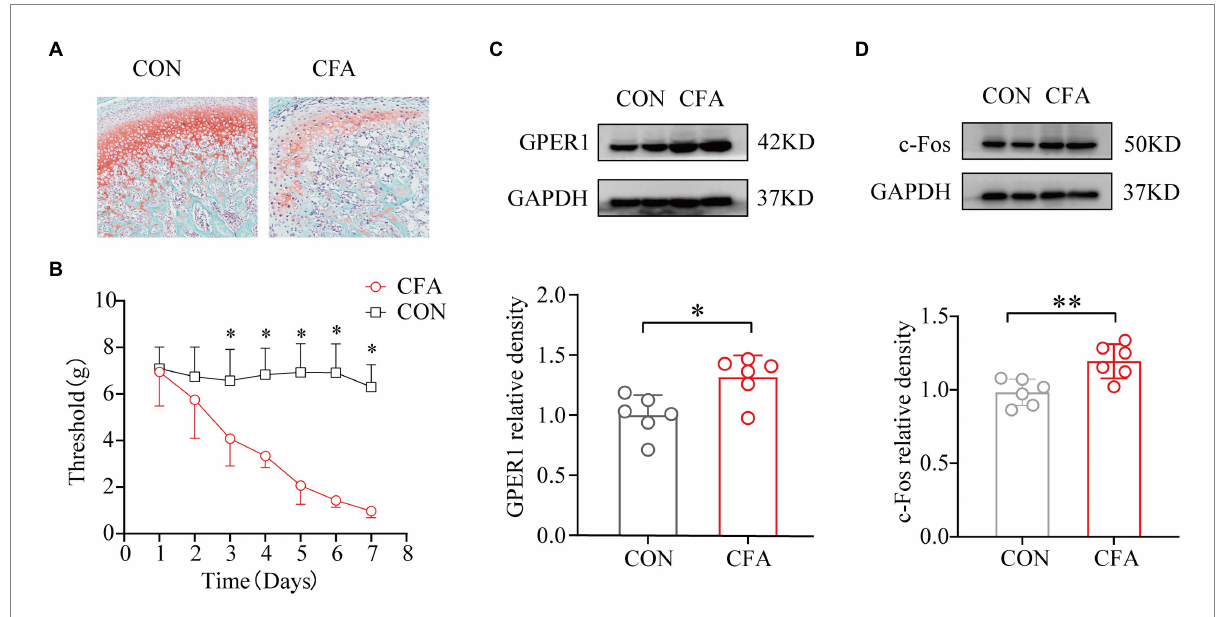
FIGURE 1 Development of mechanical heterotopic pain, GPER1, and c-Fos expression increased in RVM of CFA-induced chronic pain model. Morphological characteristics of the temporomandibular joint cartilage in rats. (A) Articular cartilage staining of cartilage tissues with red solid green showed a significant loss of proteoglycan in the CFA group compared with the CON group, indicating significant bone destruction of the tissue. (B) Determination of orofacial pain threshold in rats. Development of mechanical ectopic pain in rats. a Significantly lower orofacial pain thresholds were significantly lower 3 days after CFA injection compared with 3 days after NS injection. (C, D) WB assay of GPER1 and c-Fos expression in RVM showed that GPER1 and c-Fos protein levels were upregulated in the CFA group compared with the CON group. Quantification of normalized WB experiments showed a significant increase in the CFA group. All data were normalized to the GAPDH control group. Data represent the mean ± SD. (B) was measured with two-way repeated ANOVA followed by the Bonferroni post hoc test. A significant decrease in the thresholds was observed after 3 days of NS infusion compared with those detected after 3 days of CFA infusion. (C, D) were measured with statistical analysis was performed using independent samples t-test. * p < 0.05, ** p < 0.01. n = 6 per group. Compared with the CON